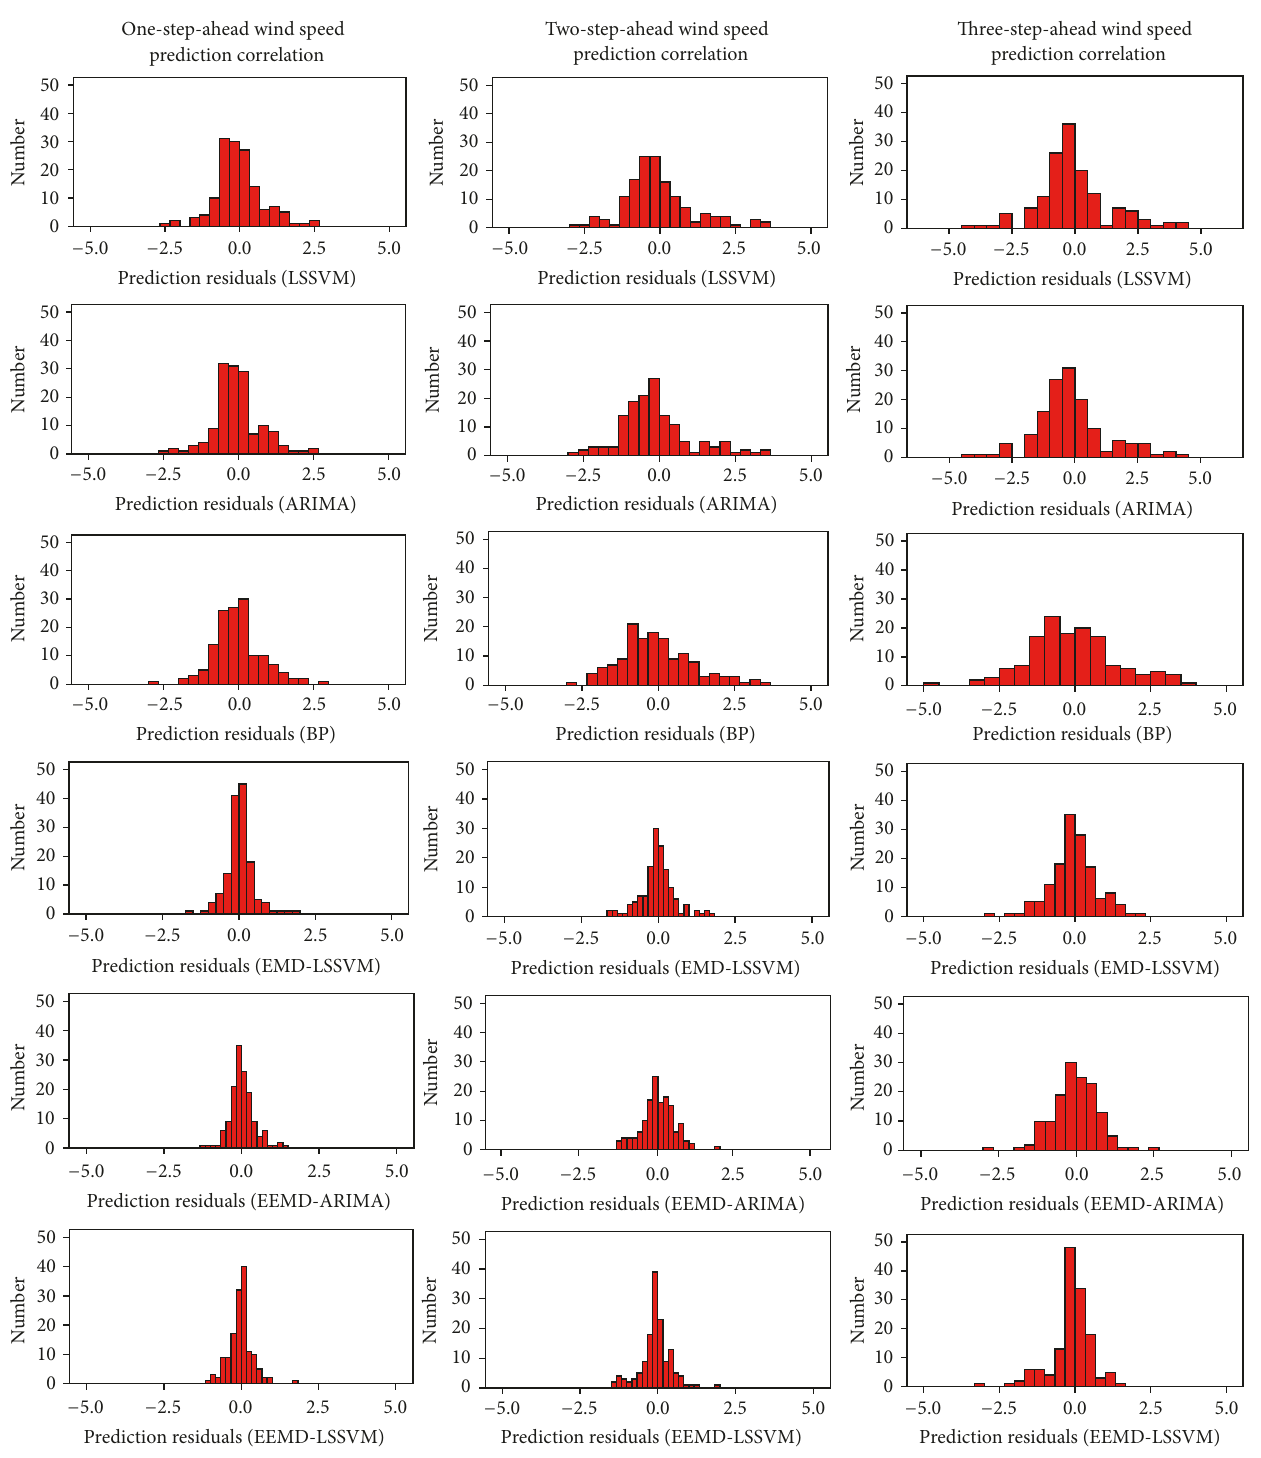
Figure 10: Histograms of prediction residuals for different models (Case